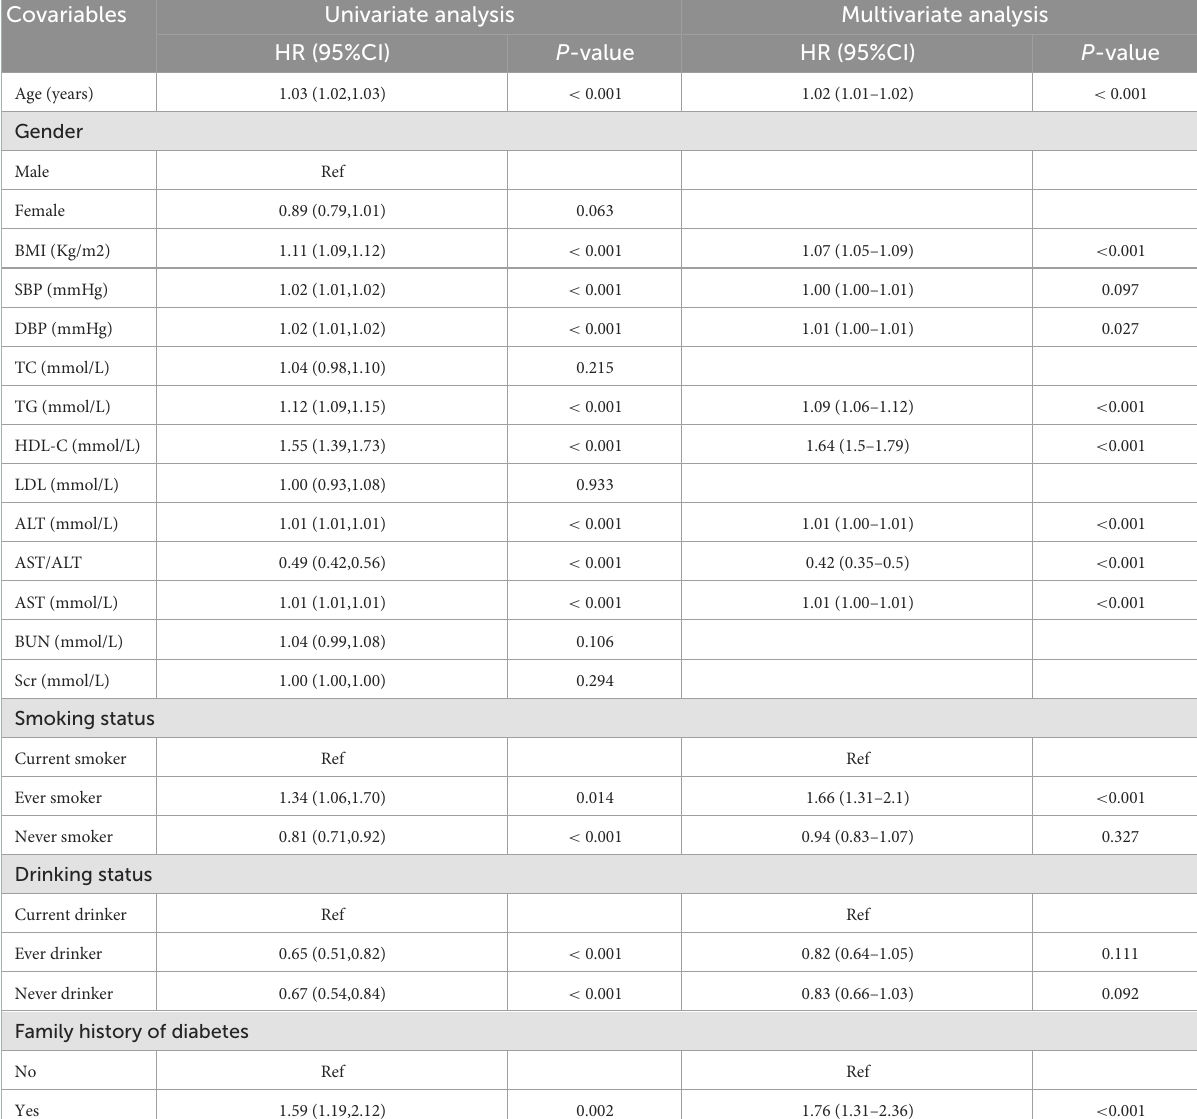
TABLE 3 Results of univariate and multivariate analysis and risk factors of diabetes. Covariables Univariate